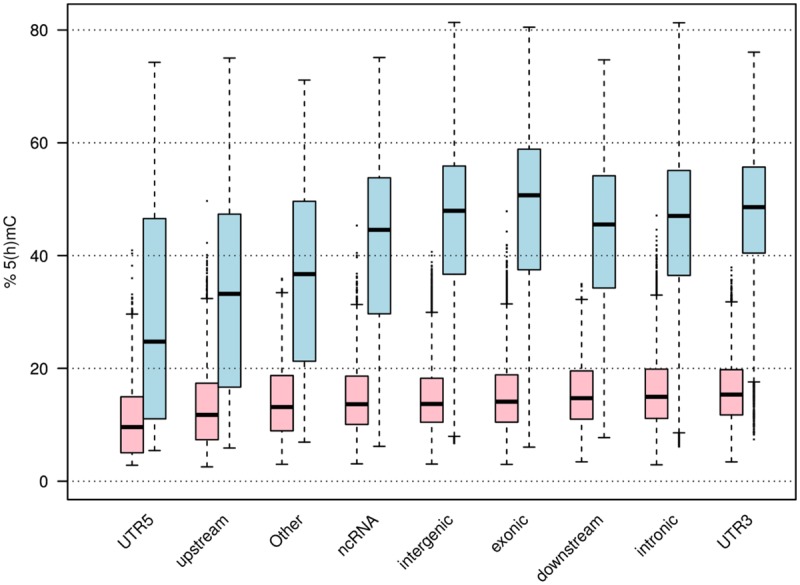
Distribution of 5mC (blue) and 5hmC (pink) levels across regions.The lowest median levels of both are in 5’UTR’s, however, beyond that there is little correlation between 5mC and 5hmC levels. Median 5hmC levels are similar across all regions, while 5mC levels show greater variation.